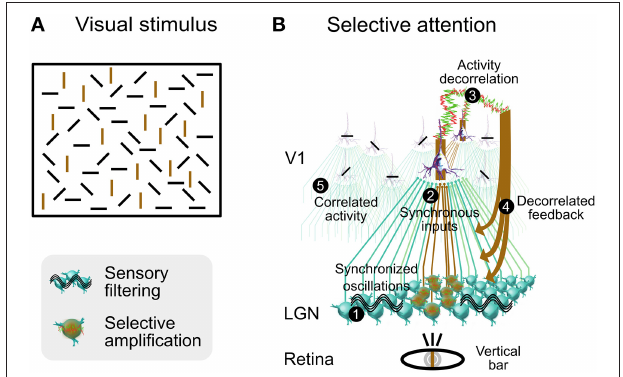
FIGURE 9 | Speculative role of synaptic bombardment decorrelation and thalamic oscillations in selective attention. (A) Visual stimulation composed of bars of various orientation. Focusing attention on a single bar (for instance vertical) will slowly segregate all other bars of same orientation from the context made of other bars of dissimilar orientation. Vertical bars are colored in brown for illustration purposes only. (B) Presumed functional steps involved when focusing attention on a vertical bar (see text for details). Bars shown on each neuron illustrate the orientation preference. Columnar organization of V1 circuits is not illustrated although each cortical neuron shown in this schema belongs to a different orientation column. Modified from Béhuret et al.